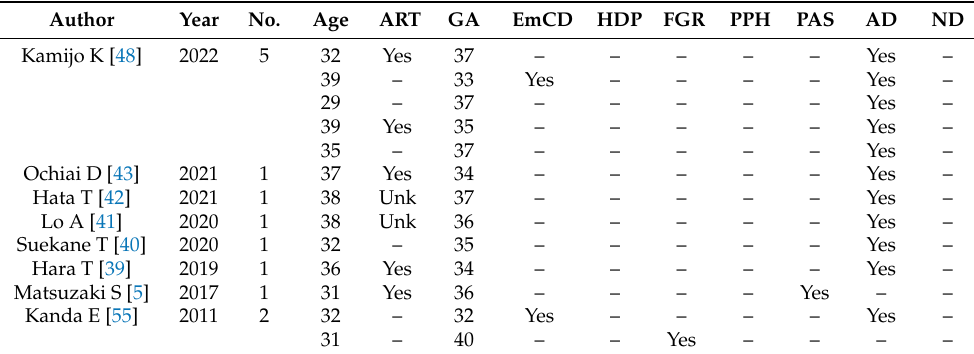
Table 2. Metadata of previous studies examining the obstetric outcomes of women with type III vasa previa.